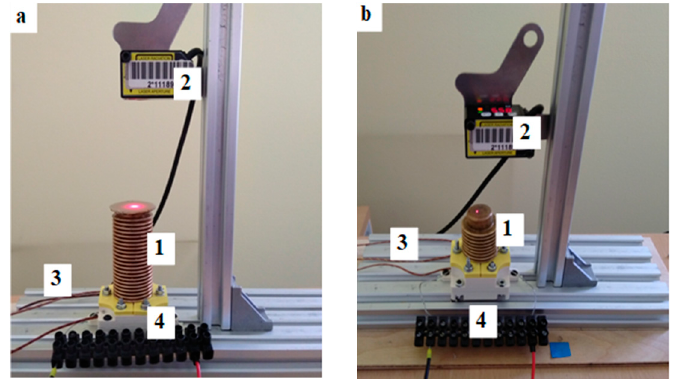
Figure 5. Stand for measuring elongation with bellow actuators: ( a ) bellow B, ( b ) bellow M, 1—actuator, 2—laser distance sensor, 3—outputs of thermocouples, 4—connection of power supply.